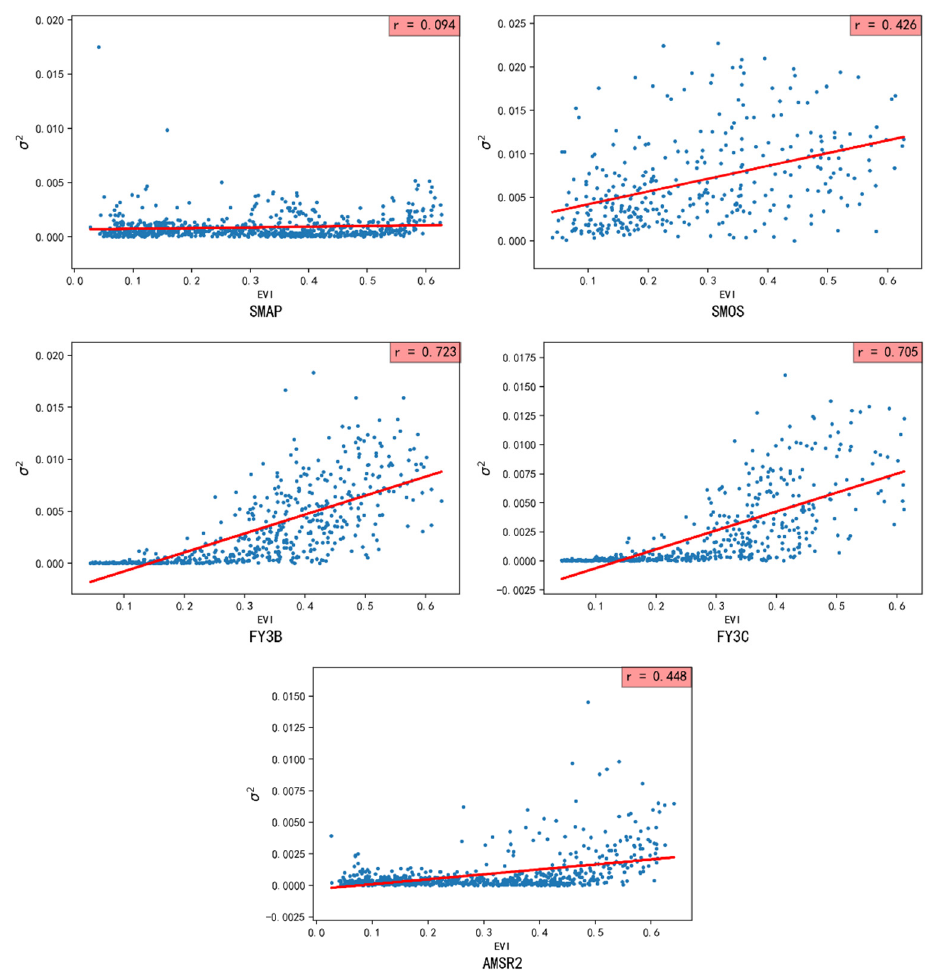
Figure 10. Scatterplots of the TC σ 2 for the SMAP, SMOS, FY3B, FY3C, and AMSR2 passive satellite data and EVI.